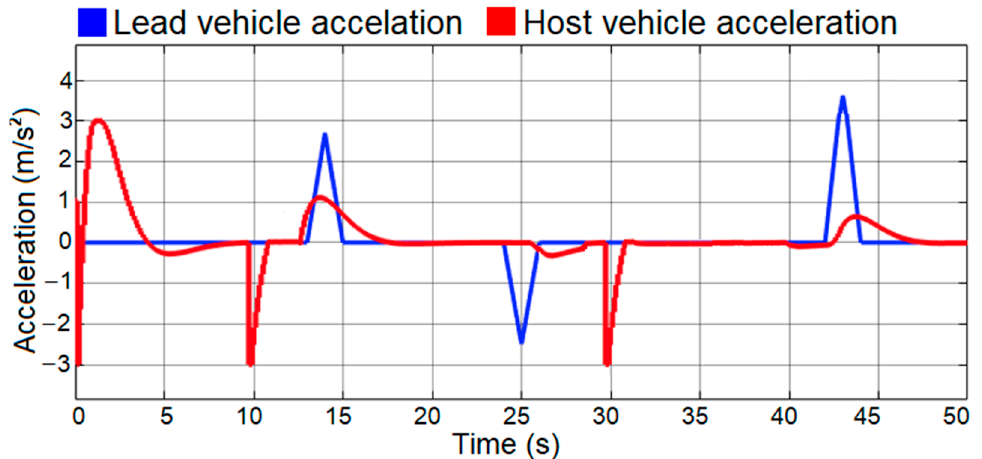
Figure 17. Acceleration of the leading vehicle and host vehicle (results from simulation).